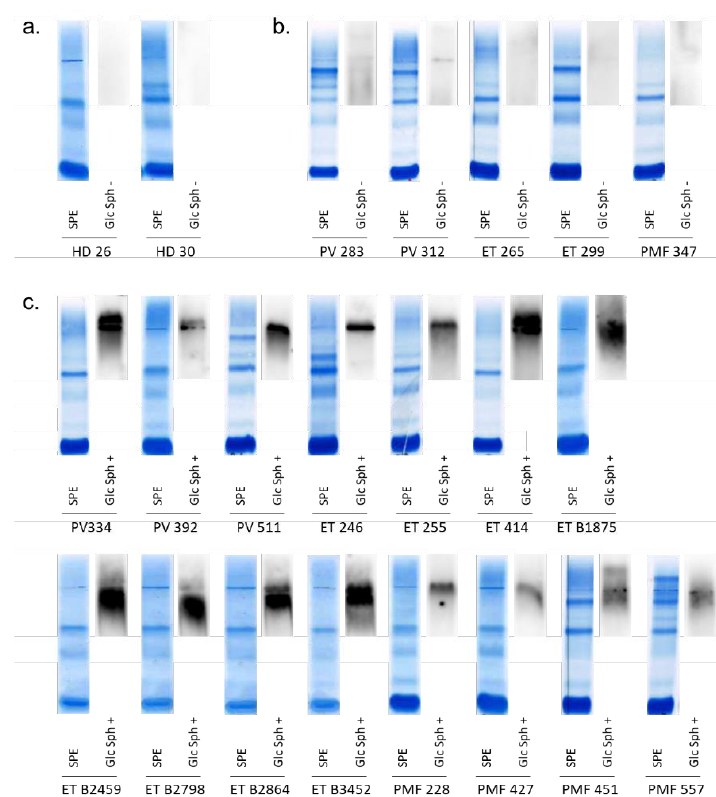
Figure 5. GlcSph-reactivity of serum IgGs from PV, ET, PMF patients. GlcSph-specific immunoblotting assays were performed as described in Methods. (a,b,d) Both the gel of serum protein electrophoresis (SPE), after coloration, and the result of the GlcSph immunoblot, revealed by chemiluminescence, are shown; note that migration pattern may vary. ( a ) Example of 2 / 54 HDs with no GlcSph-reactive IgG in serum. ( b ) Examples of 5 / 60 MPN patients with no GlcSph-reactive IgG in serum. ( c ) 15 / 15 MPN patients with GlcSph-reactive IgGs in serum.